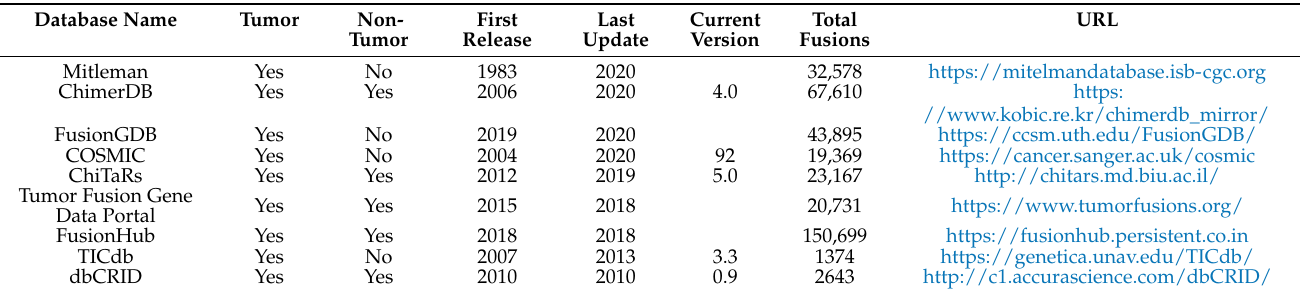
Table 1. Available databases hosting fusion